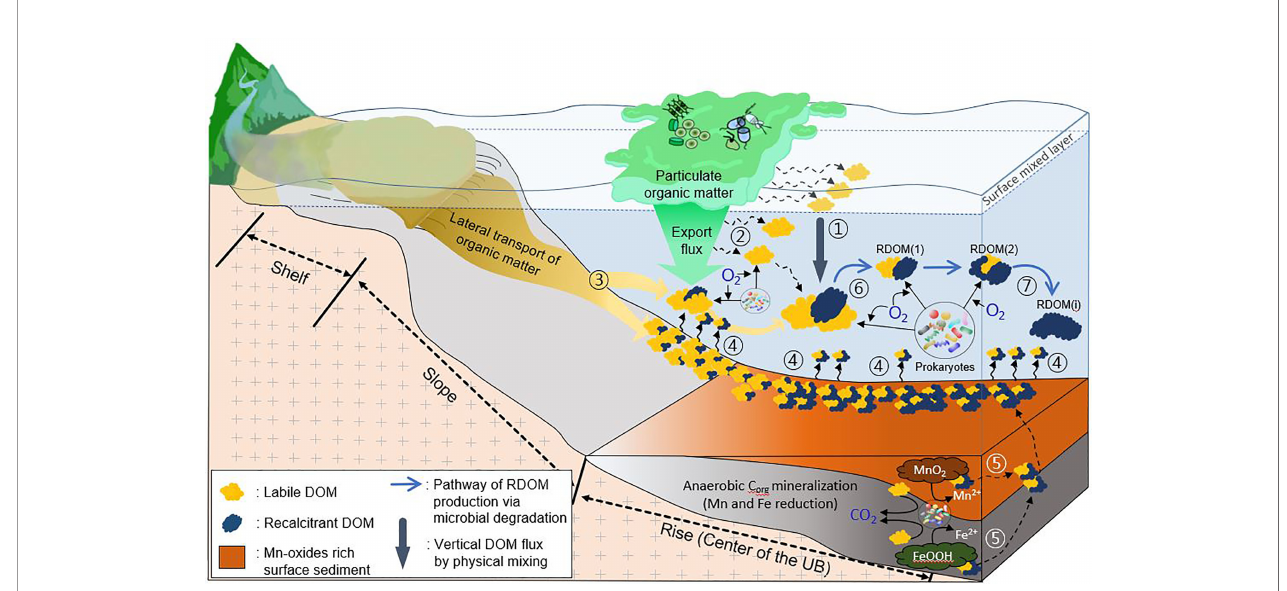
FIGURE 7 | Schematic summary of microbially mediated cycles of DOM in the deep-water column of the UB. Each step (circled number) is described in the text. The present study deals with steps 4, 6 and 7, and also proposes the potential signi fi cance of step